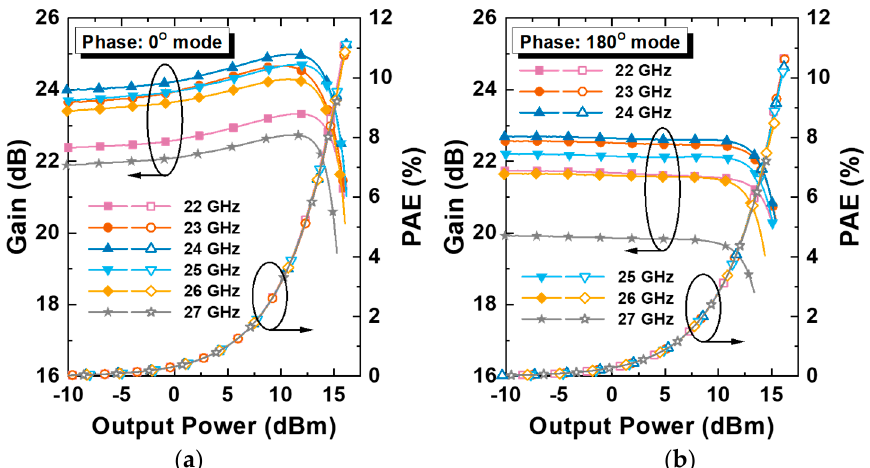
Figure 10. Measurement results: gain and PAE according to the output power: ( a ) 0°- and ( b ) 180°- modes.